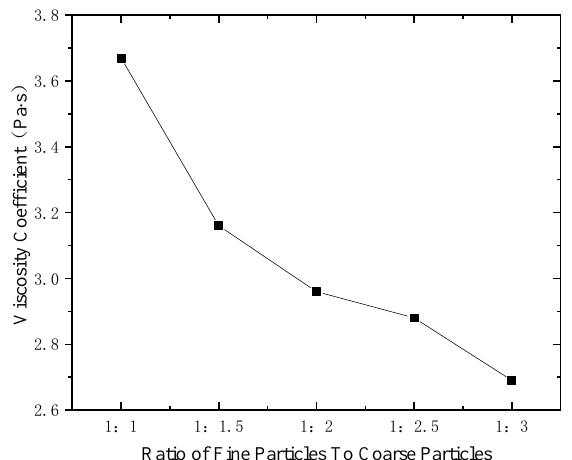
Figure 11. Relation between viscosity coefficient and different ratios of fine particles to coarse particles.